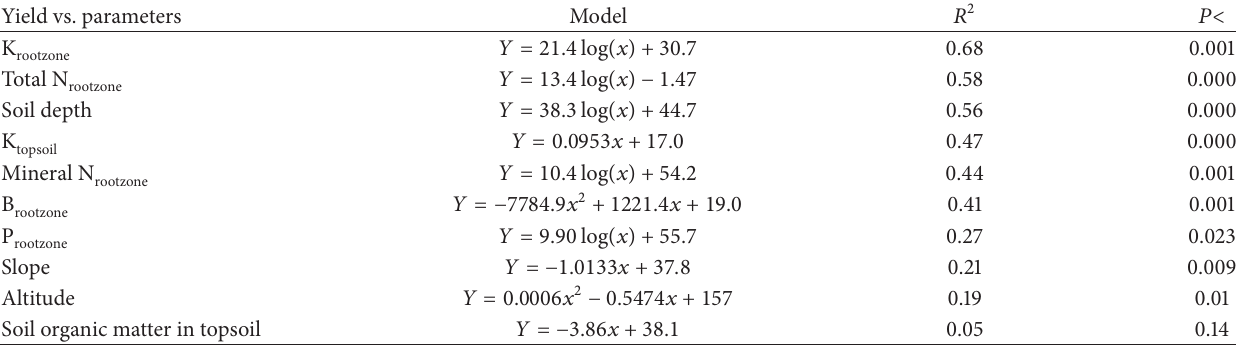
Table 6. Combining “ Log K